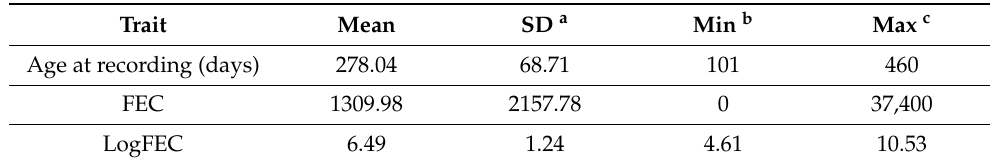
Table 1. Descriptive statistics for animal age at recording (days), faecal egg counts (FEC) and LogFEC for the total database used ( n = 19,547).